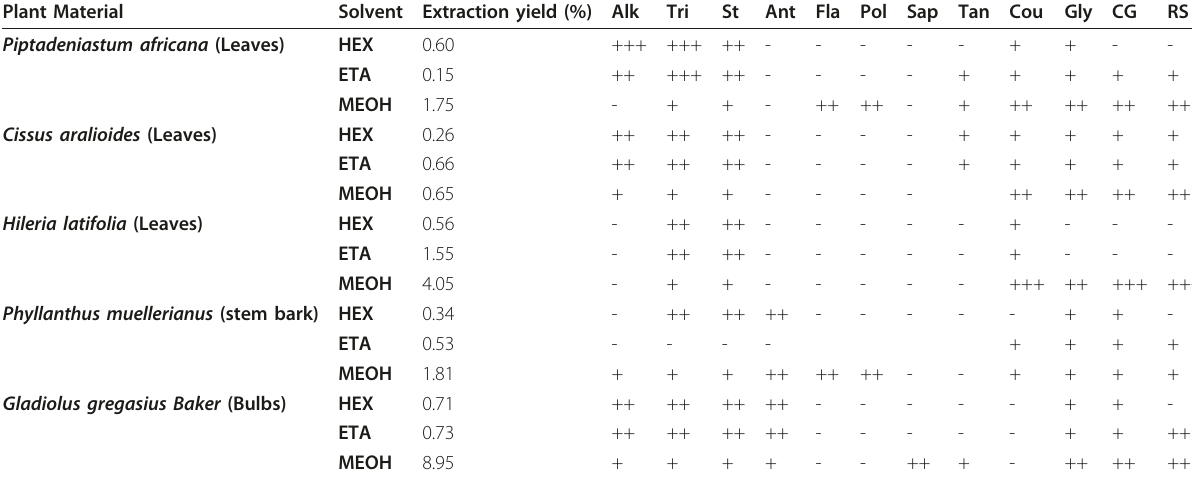
Table 1 Extraction yield (%) and results of phytochemical screening of various medicinal plant ’ s extracts Plant